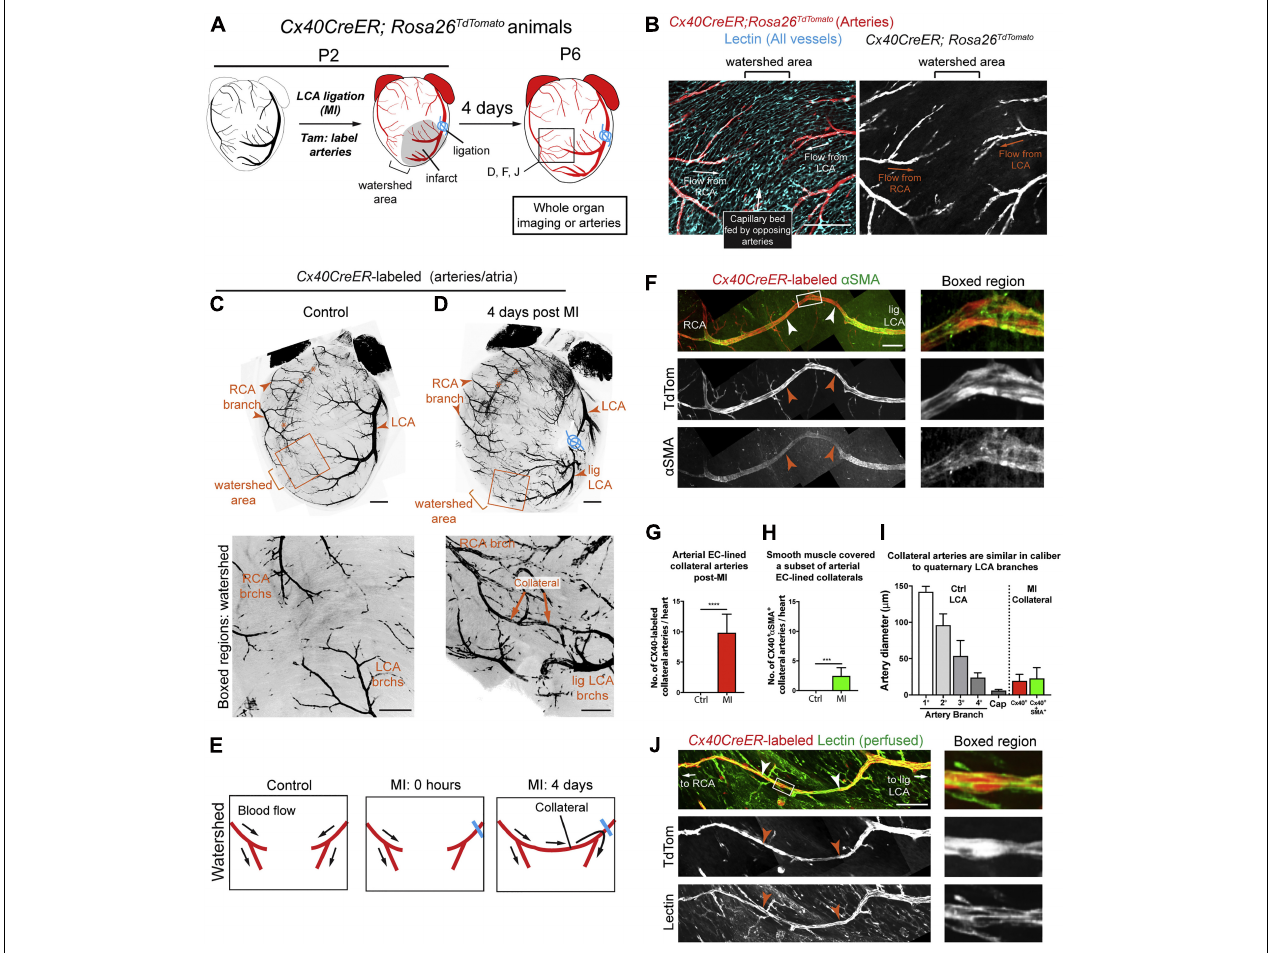
FIGURE 1 | Extensive Collateral Artery Formation in the Neonatal Mouse Heart 4 days after MI. (A) Experimental design where Cx40CreER -labeled arteries are shown in red. (B) Confocal image of a watershed area from a P2 control heart. The capillary bed (cyan) is fed by left coronary artery (LCA) and right coronary artery (RCA). (C,D) Confocal images (anterior views) of control (C) and myocardial infarction (MI) (D) hearts. Arterial ECs are shown in black. MI induced collateral arteries that connect ligated (lig) branches (brchs) of the LCA with RCA branches across the watershed area (boxed regions). Asterisks indicate the RCA showing through from the posterior heart wall. (E) Schematic of how collateral arteries restore blood flow (arrows) to injured myocardium. Arteries, red; ligation, blue. (F) Some Cx40CreER -labeled collateral arteries contain smooth muscle (white and red arrows). (G,H) Quantification of Cx40CreER -labeled (G) and smooth muscle-covered (H) collateral arteries. Hearts: n = 8 control, n = 12 MI. (I) Collateral arteries were similar in diameter to quaternary (4 ◦ ) branches. Arteries: n = 24 Cx40 + , n = 9 α SMA + . (J) Collateral arteries were perfused (white and red arrows). Cap, capillaries; P, postnatal; Tam, tamoxifen; EC, endothelial cells; TdTom, tdTomato. Scale bars: (B) , 200 µ m; (C,D) low magnification, 500 µ m; (C,D) boxed region, 200 µ m; (F,J) , 200 µ m. Error bars indicate SD. *** p ≤ 0.001, **** p ≤ 0.0001. Adopted from Das et al.